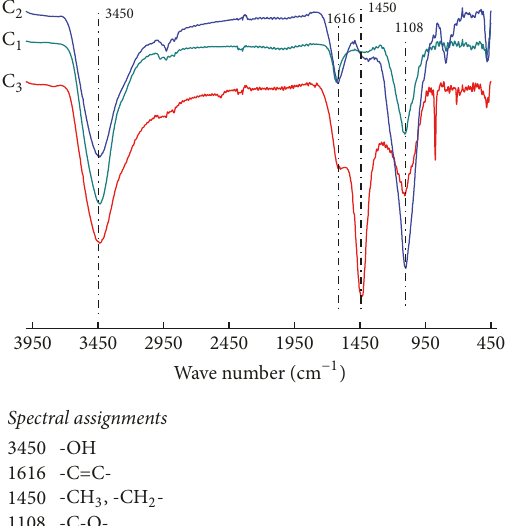
Figure 2: FT-IR spectral scan of commercial activated carbon (C 1 ), rice husk carbon (C 2 ), and nut shell carbon (C 3